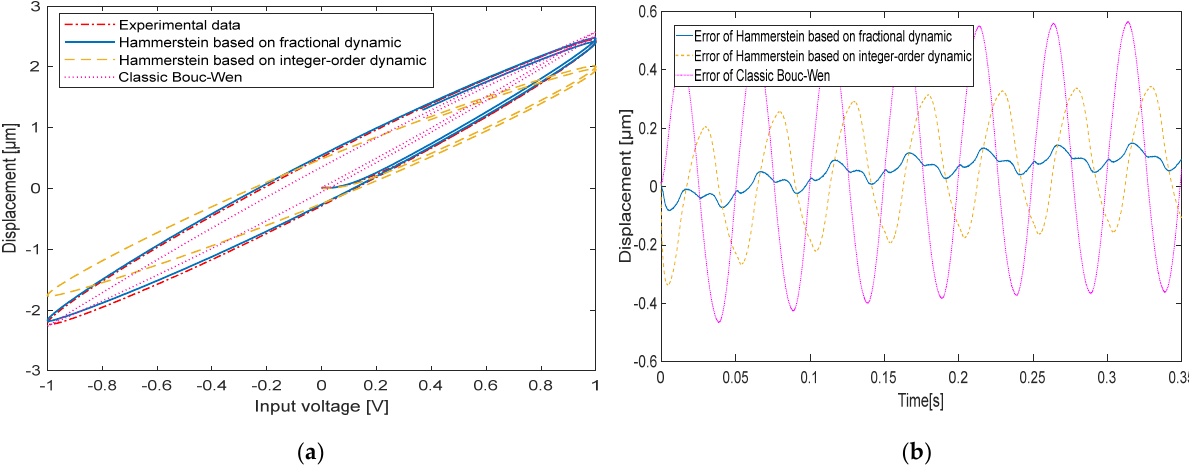
Figure 9. The comparison between experimental data and the Hammerstein model at 20 Hz: ( a ) Hysteresis loop; ( b ) Time curve.